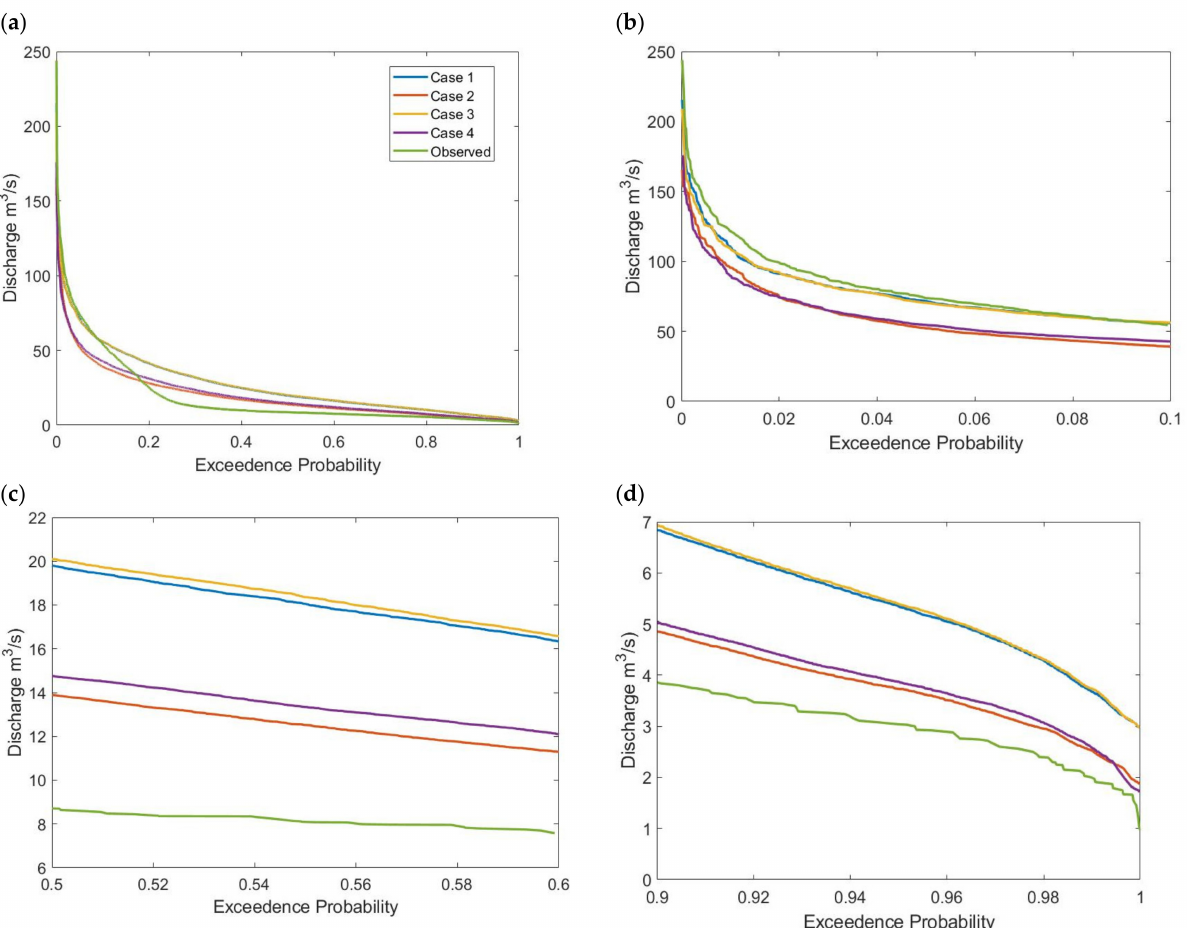
Figure 4. Flow Duration Curve for ( a ) total flows ( b ) high flows (0–10%) ( c ) median flows (50–60%) ( d ) low flows